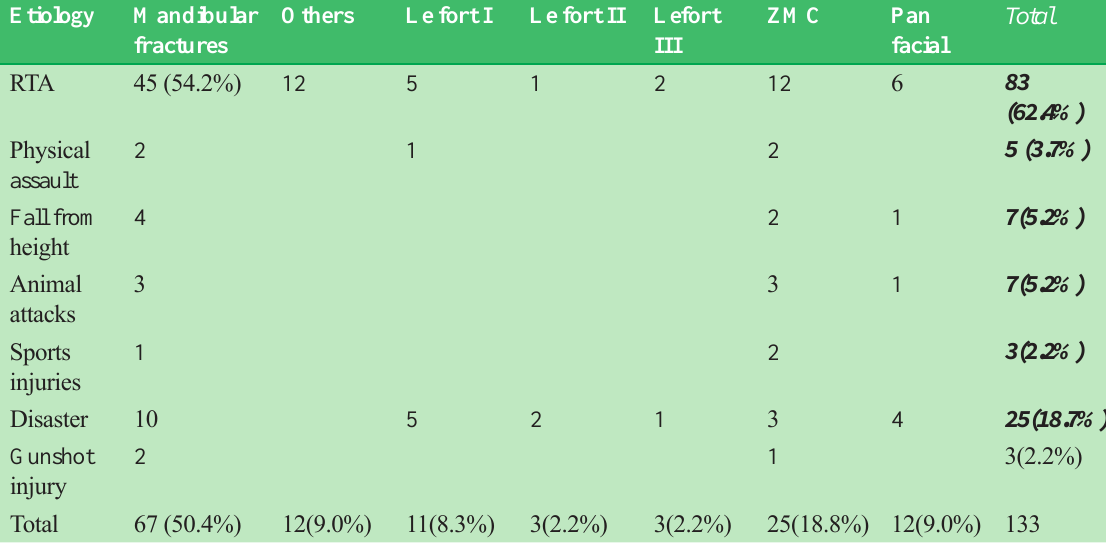
Table1: Site and etiological distribution of maxillofacial injuries.